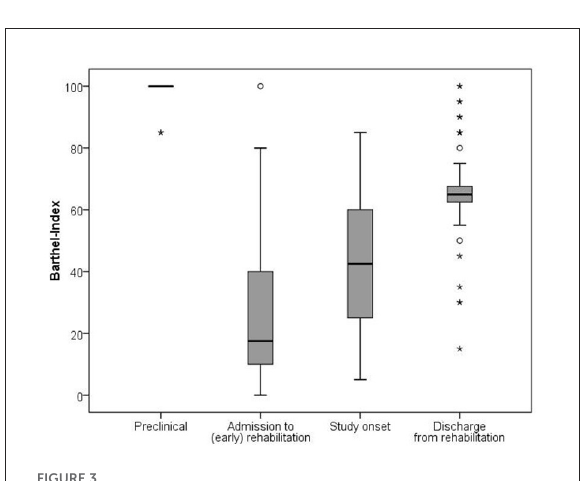
FIGURE3 Development of the Barthel Index from preclinical state throughout rehabilitation. The comparison between the four time points showed significant differences and large effect sizes (Friedman-test and effect size with r preclinical-hospital admission ( p < 0.001, r